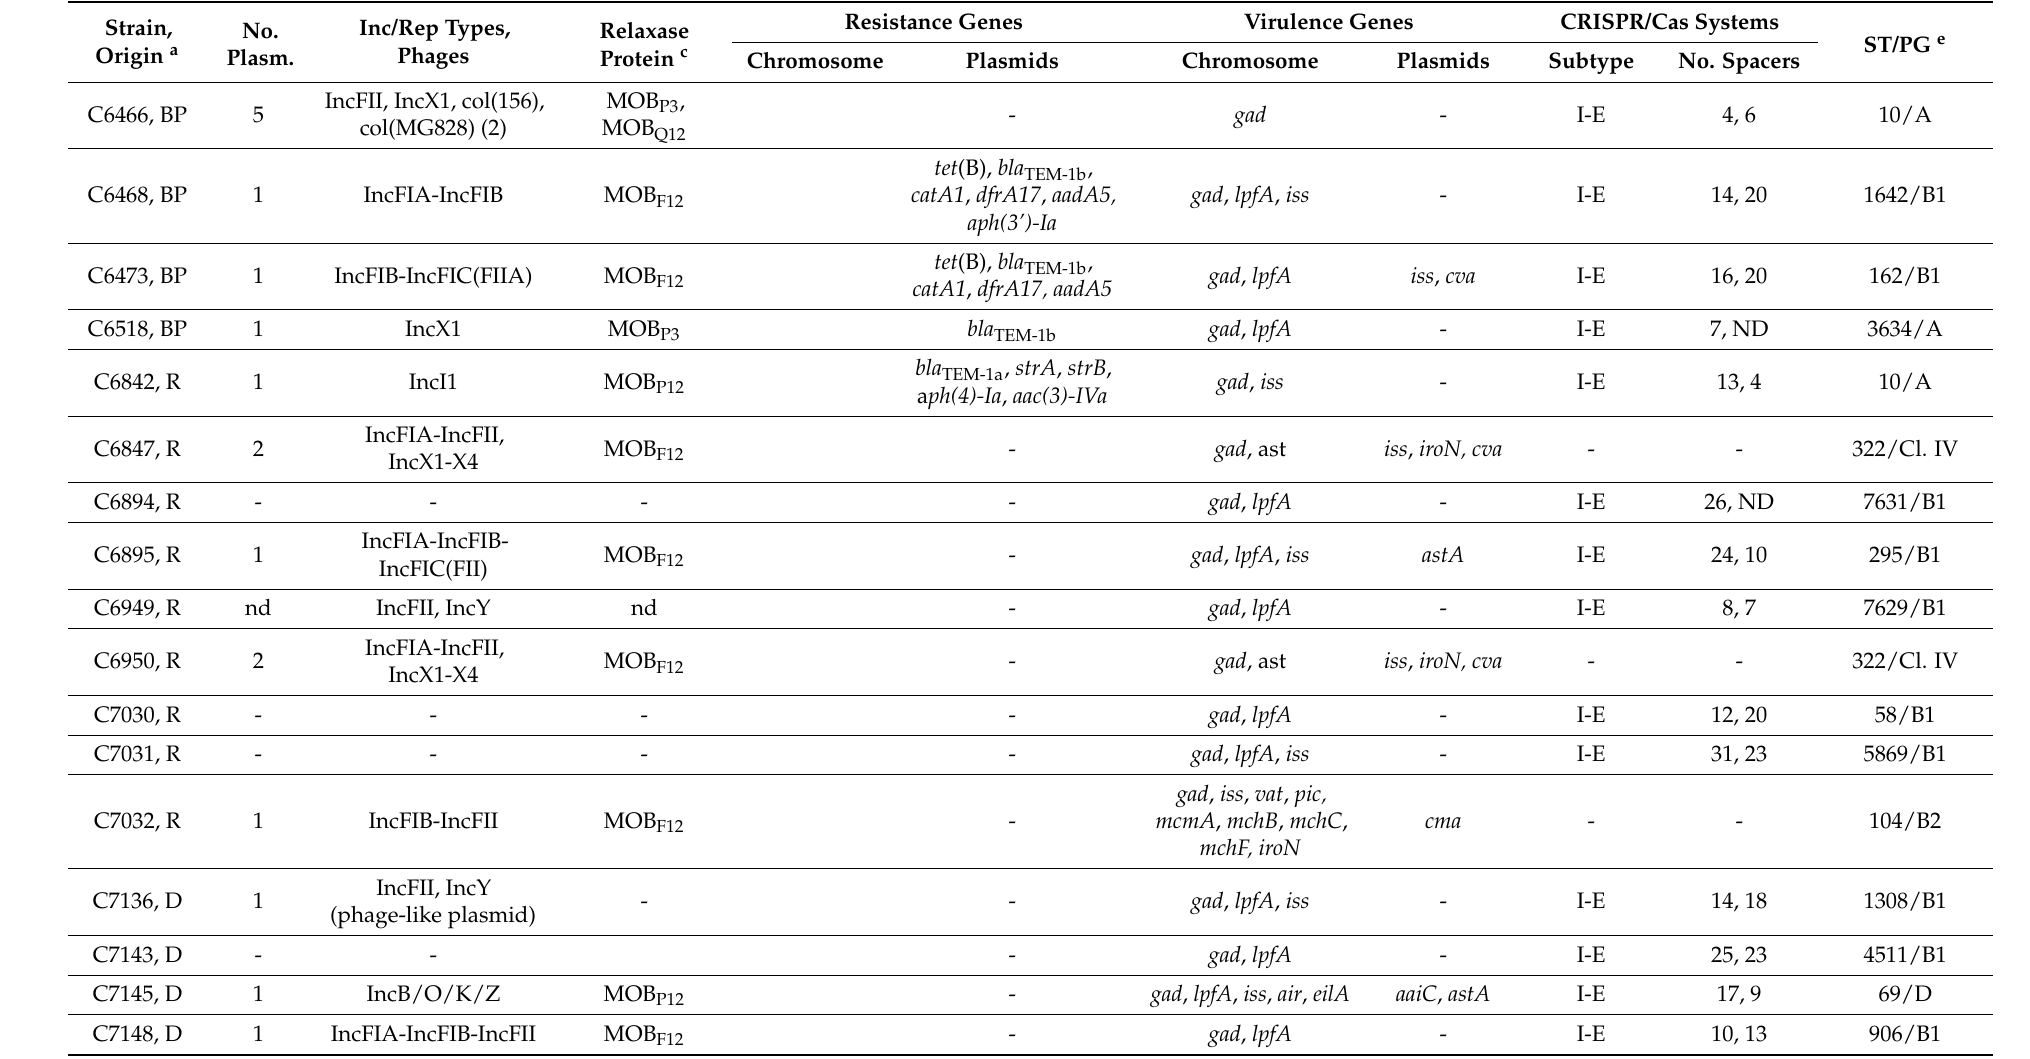
Table 2. Genetic features of commensal E. coli isolates from wildlife based on in silico WGS